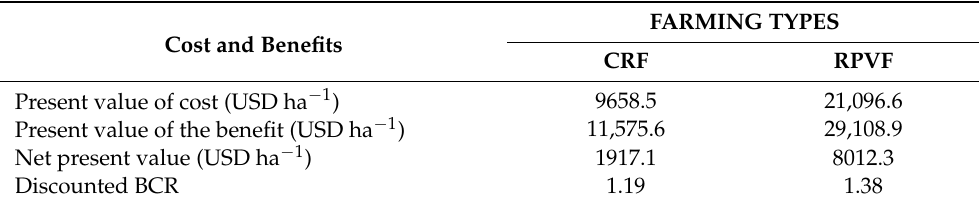
Table 5. Analysis of financial viability in terms of net present value (NPV) and discounted BCR of CRF and integrated